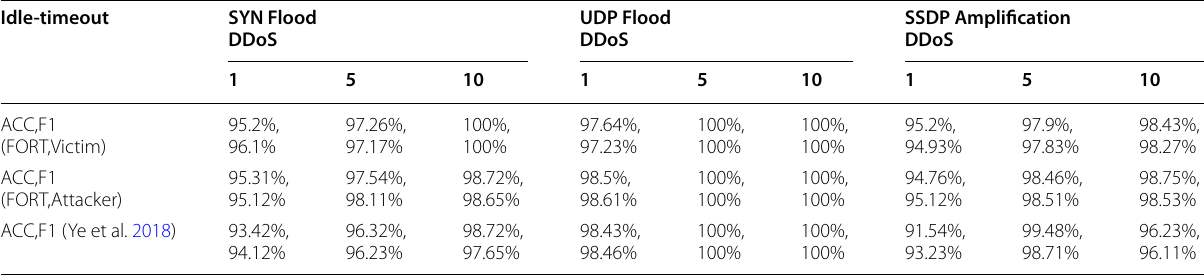
Table 2 Performance with different idle-timeout